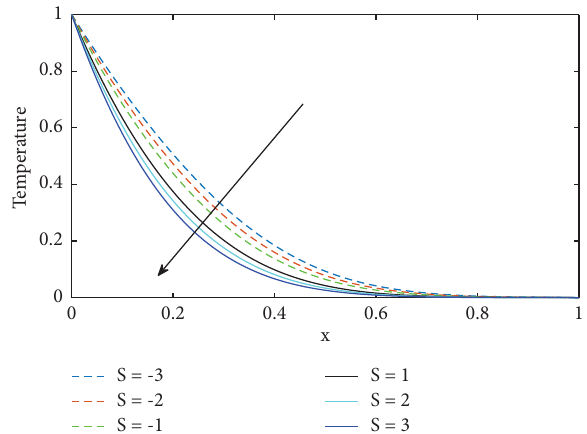
Figure 17: Temperature profles for diferent values of S .